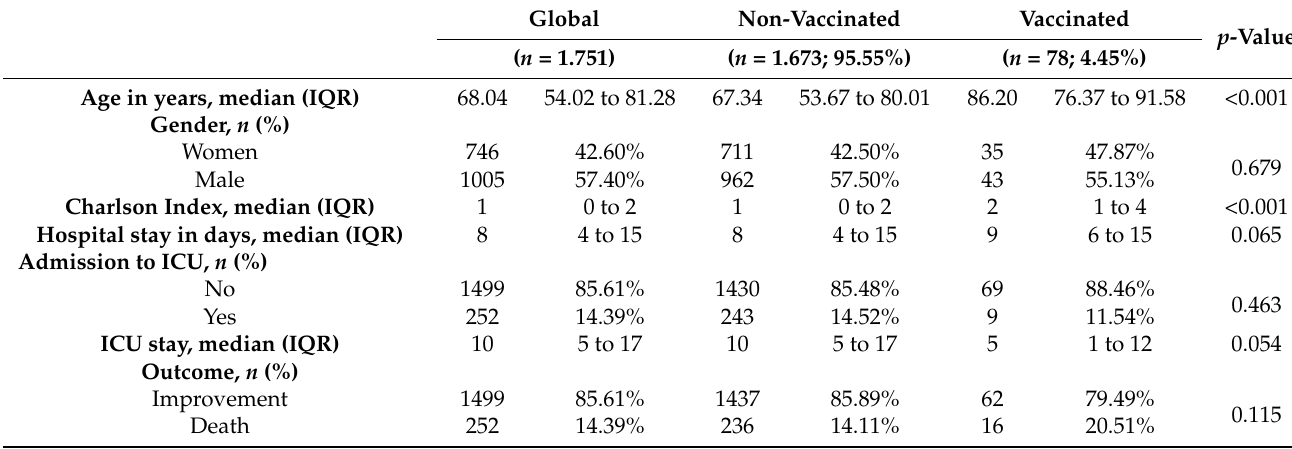
Table 1. Description of the participants’ characteristics.